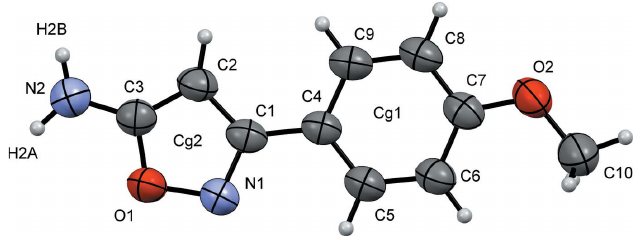
Figure 2 The molecular structure of (II) with displacement ellipsoids drawn at the 50% probability level.